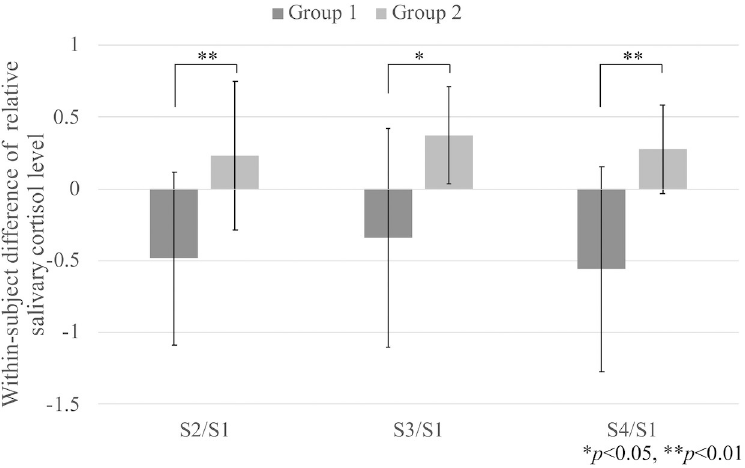
Fig 6. The within-subject difference in the changes in salivary cortisol levels between Day 1 and Day 2. The participants in Group 1 called an unfamiliar person on the phone while hugging a Hugvie on Day 1, followed by a phone call without a Hugvie (only using a mobile phone) on Day 2. The participants in Group 2 followed the opposite conditions on both days.